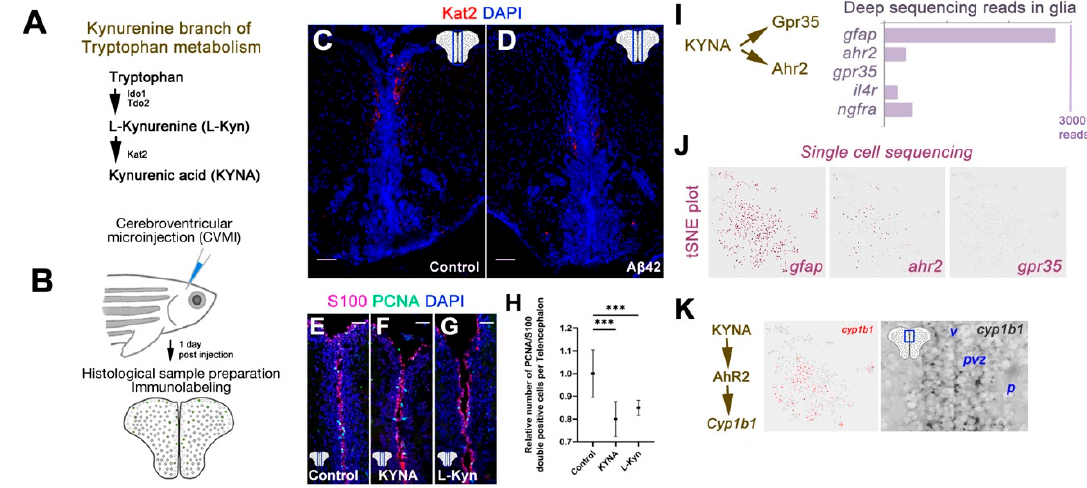
Figure 1. Kynurenic acid signaling is through Ahr2 in adult zebrafish brain. ( A ) Catabolic cascade from tryptophan to kynurenic acid. ( B ) Cerebroventricular microinjection paradigm. ( C , D ) Immunohistochemical staining for Kat2 in control ( C ) and A β 42-injected ( D ) adult zebrafish brain sections. ( E – G ) Immunohistochemical staining for S100 and PCNA in control ( E ), KYNA-injected ( F ) and L-Kynurenine-injected ( G ) zebrafish brain sections. ( H ) Quantification of proliferating glial cells of conditions in ( E – G ). ( I ) Deep sequencing reads of KYNA receptors ahr2 and gpr35 as well as other receptors of neural stem cells, il4r and ngfra . Reads for gfap is for comparison. ( J ) tSNE plots from single cell sequencing in adult zebrafish telencephalon in progenitor cells. Expression of gfap, ahr2 and gpr35 shown. ahr2 is the only receptor for KYNA in progenitor cells. ( K ) Ahr2 signaling regulates cyp1b1 expression. Cyp1b1 is present in progenitor cells as determined in single cell sequencing, and in situ hybridization. Scale bars equal 50 µ m. Statistical calculations and values are provided in Table S1.